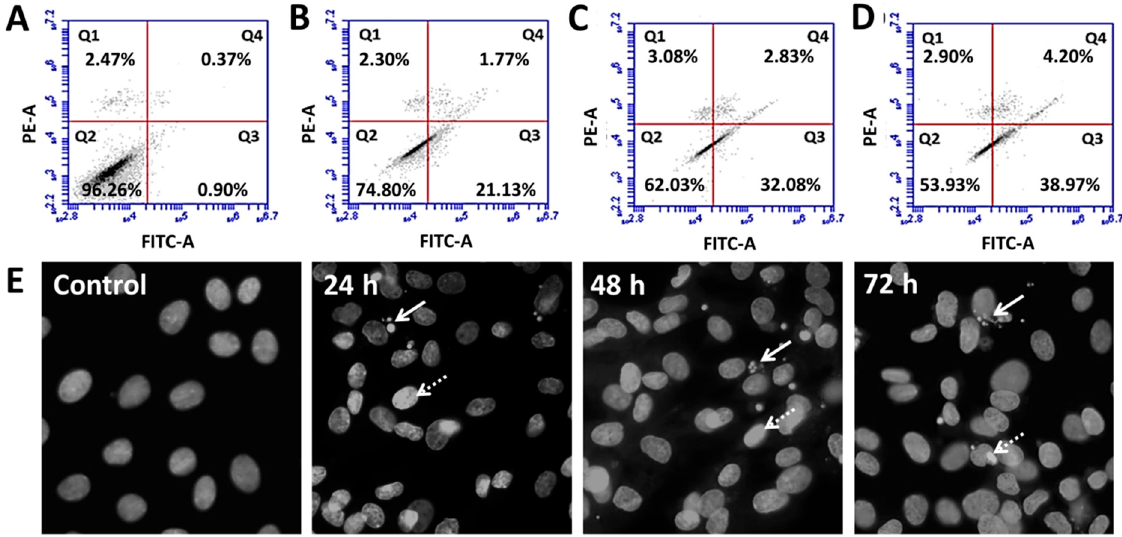
Figure 4. The apoptosis analysis of HepG2 cells over time. ( A – D ) displayed the representative apoptosis map of HepG2 cells from control group, 24 h, 48 h, and 72 h of SFA-CHCl3 extract treatment, respectively (Q1 indicates necrotic cells, Q2 indicates the live cells, Q3 indicates the early apoptotic cells, and Q4 indicates the late apoptotic cells). ( E ) Nuclear morphology of HepG2 cells (White arrow indicates nuclear fragmentation; dotted arrow indicates chromatin condensation). Original magnification ×400.